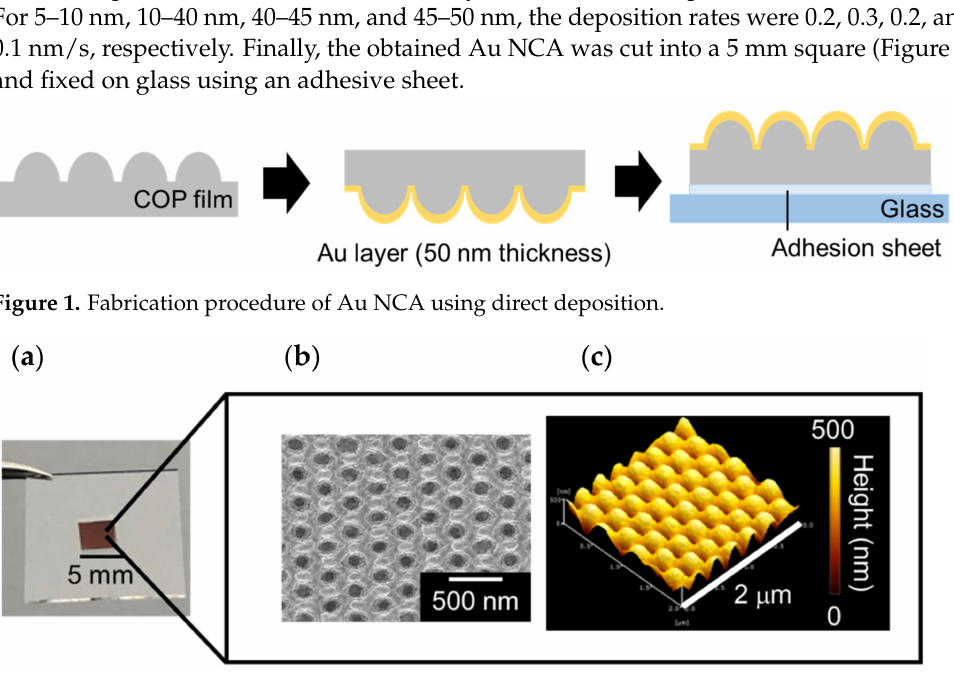
Figure 2. Images of the Au NCA ( a ) and its surface structure as observed by FE-SEM ( b ) and AFM ( c